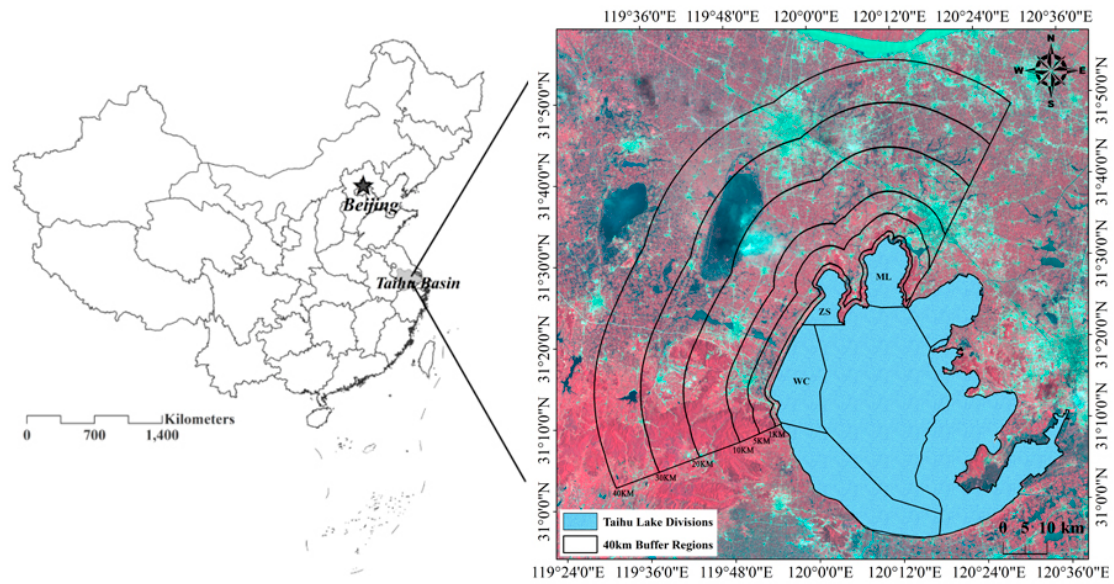
Figure 1. The location of the study site and three lake divisions.